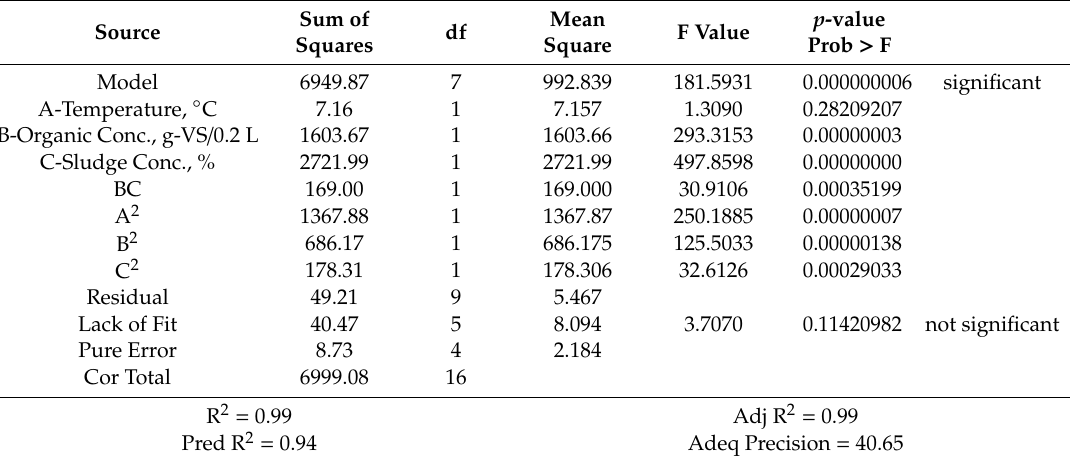
Table 6. The ANOVA table for CH 4 concentration response.